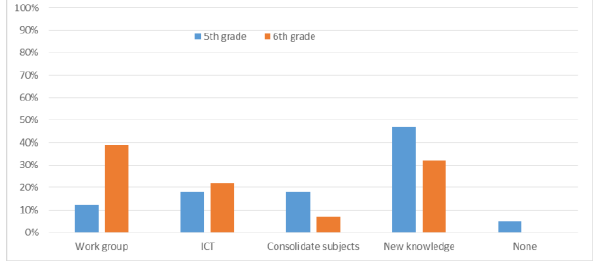
Figure 10: Second cycle students’ perceptions about improved skills with